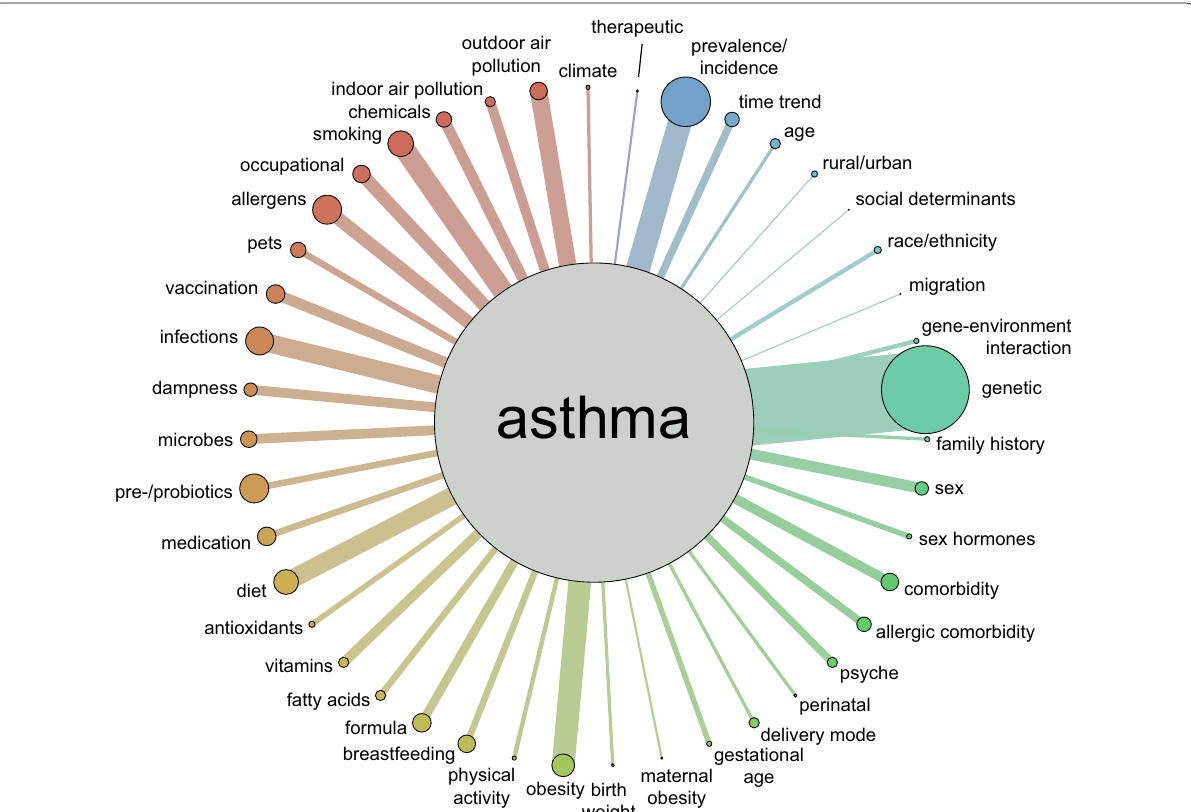
Fig. 1 Aggregated topics indexed along with asthma. The figure is based on the aggregated indexed topics which are presented in the same clockwise order as listed in Additional file 1: Table S2. Bubble diameter is proportional to the number of systematic reviews with the respective index term (this number is based on all n 421 systematic reviews on allergy epidemiology, also non-asthma systematic reviews (based on the = aggregated disease index term “asthma”), included in our previous overview [8]). Line thickness is proportional to the number of systematic reviews indexed with the connected index terms. Colours are arbitrary, covering the spectrum from blue to red in clockwise